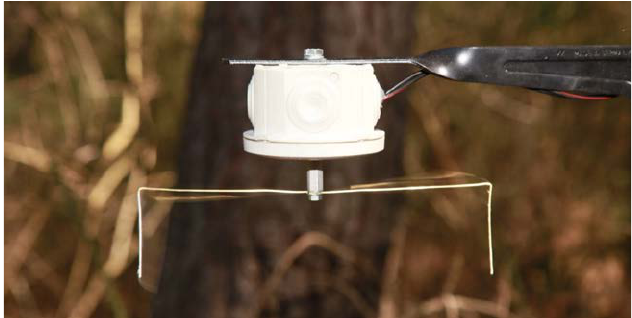
Figure 1. Running spore trap (ROTTRAP 120) coated with double-sided tape on the impaction side of the square section wire.